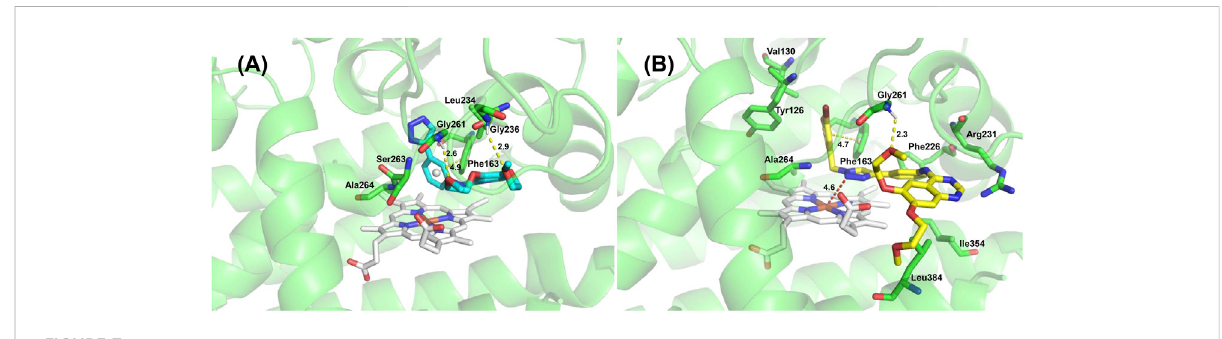
FIGURE 7 3D binding modes of compound 13 (A) and compound 14b (B) in complex with